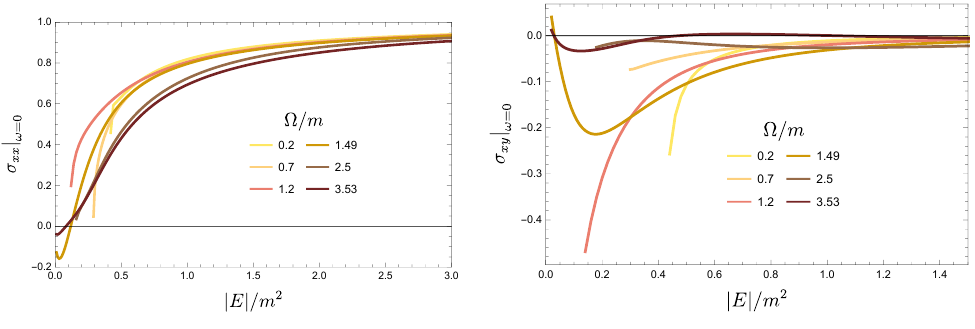
Figure 13 . DC Conductivities as a function of (cid:10) =m for various values of j E j =m 2 .